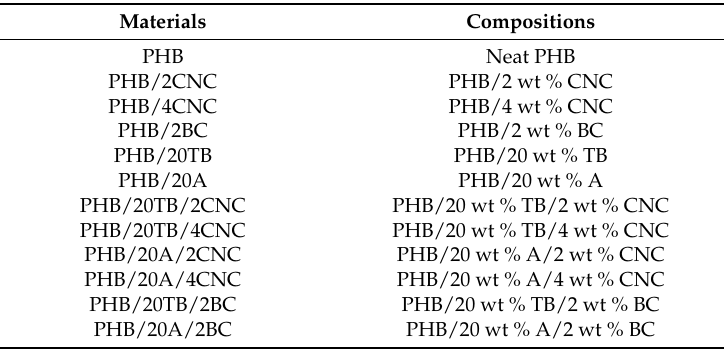
Table 1. Nomenclature used for each